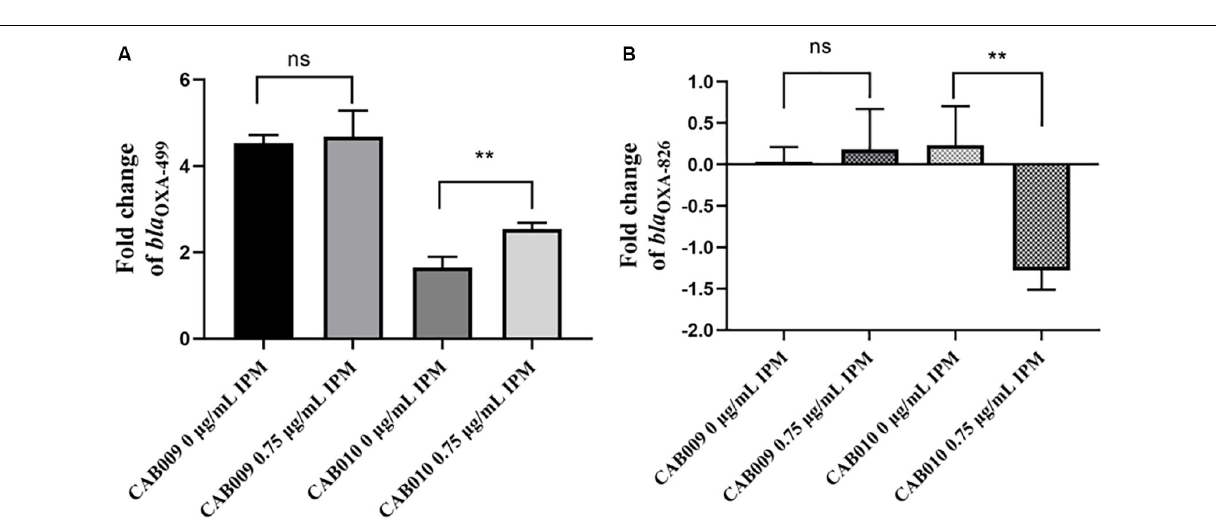
FIGURE 3 | Log 2 fold changes of (A) bla OXA − 499 and (B) bla OXA − 826 expression levels in mutants undergoing or not imipenem selection pressure. RT-qPCR analysis was performed with three biological and technical replicates per experiment. The 2 − (cid:49)(cid:49) Ct method was applied to calculate the fold change using rpoB as the reference gene and Acinetobacter pittii A1254 as the reference strain. The expression level was calculated as the log 2 fold change. The bars represent means ± SD from triplicate biological repeats. The P -values (each mutant undergoing or not imipenem selection pressure) were determined by two-tailed Student’s t -tests. ** P < 0.008; ns, not significant. IPM,